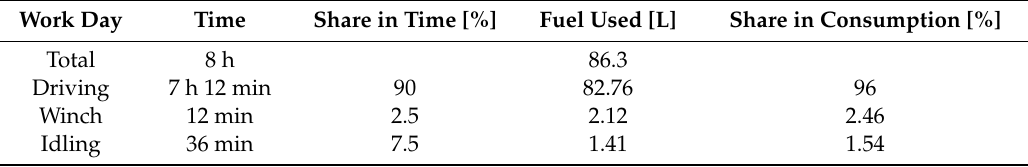
Table 11. Overall results for skidder’s work